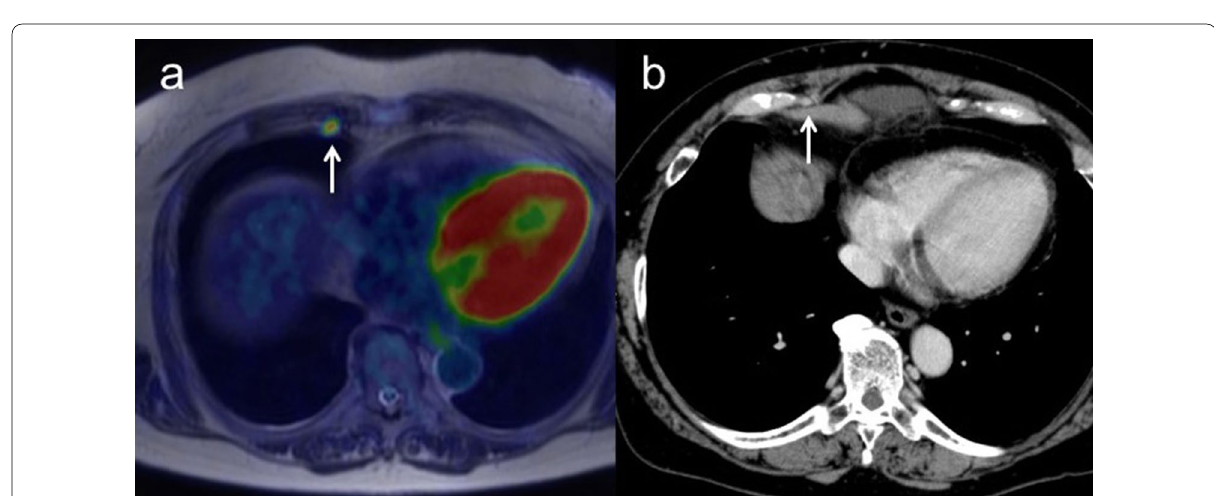
Fig. 4 a A 66-year-old woman with pathologically confirmed ovarian cancer. Axial T2-weighted PET/MR image shows a right parasternal lymph node with FDG uptake (arrow). b Contrast-enhanced CT shows a right parasternal lymph node less than 1 cm in short-axis diameter with slightly enhancement (arrow). After NAC, this lymph node decreased in size and SUV, suggesting that this node as a sign of malignancy